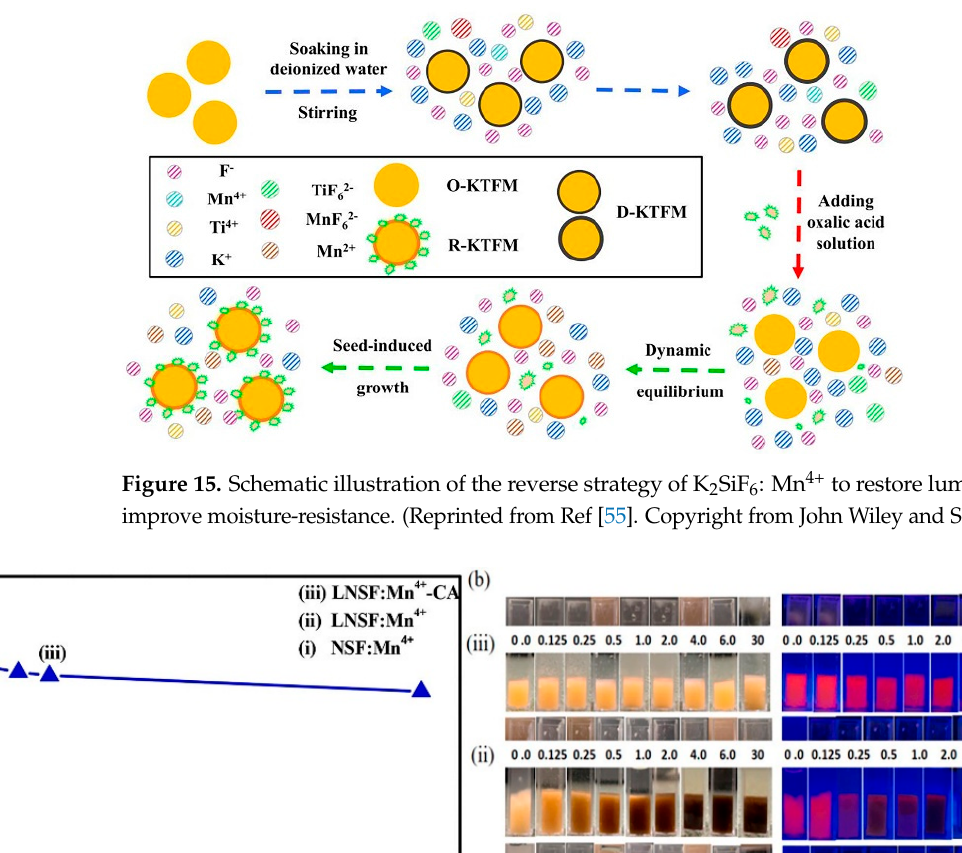
Figure 14. ( a ) Excitation and emission spectra of KGF and T-KGF; ( b ) decay curves KGF and T-KGF; ( c ) temperature-dependent relative PL intensities KGF and T-KGF; ( d ) relative PL intensities of im- mersion in water for different times of KGF and T-KGF. (Reprinted from Ref [53]. Copyright from Elsevier, 2018).